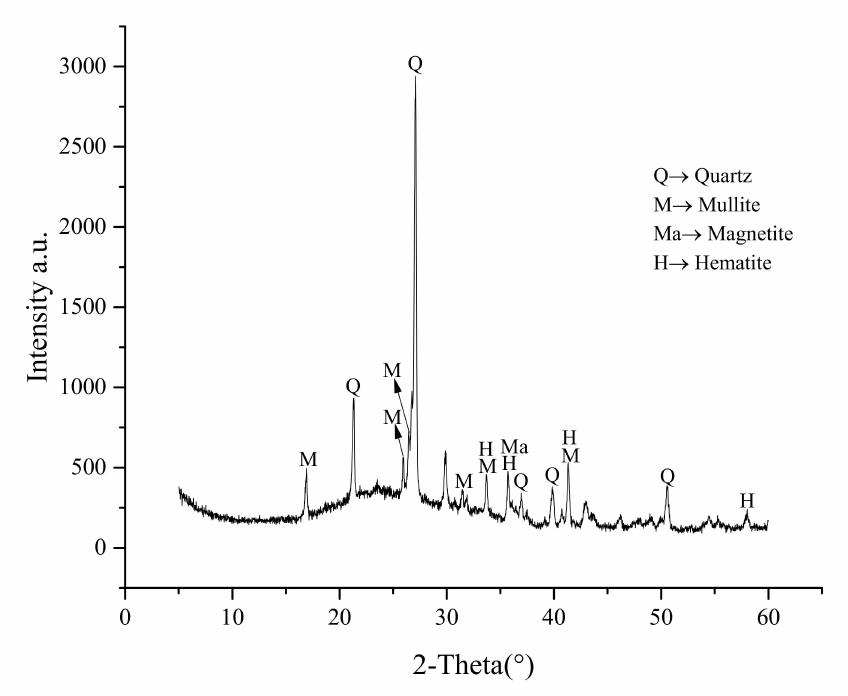
Figure 1. XRD spectra of fly ash.